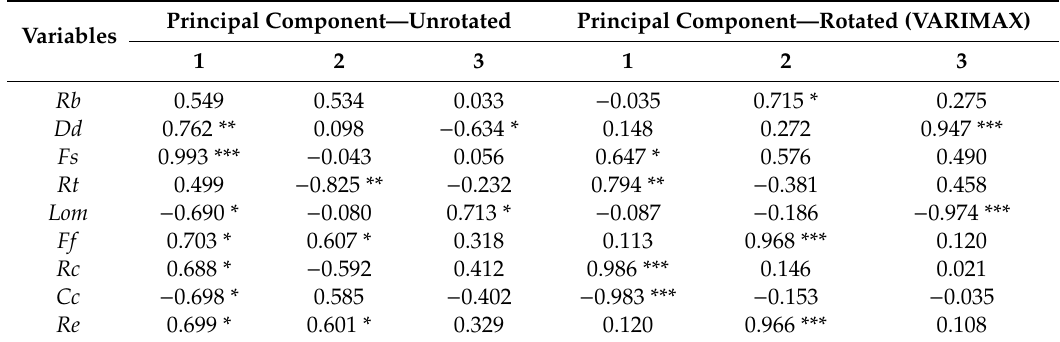
Table 8. Unrotated and rotated factor-loading matrix of morphometric variables. Principal Component—Unrotated Variables